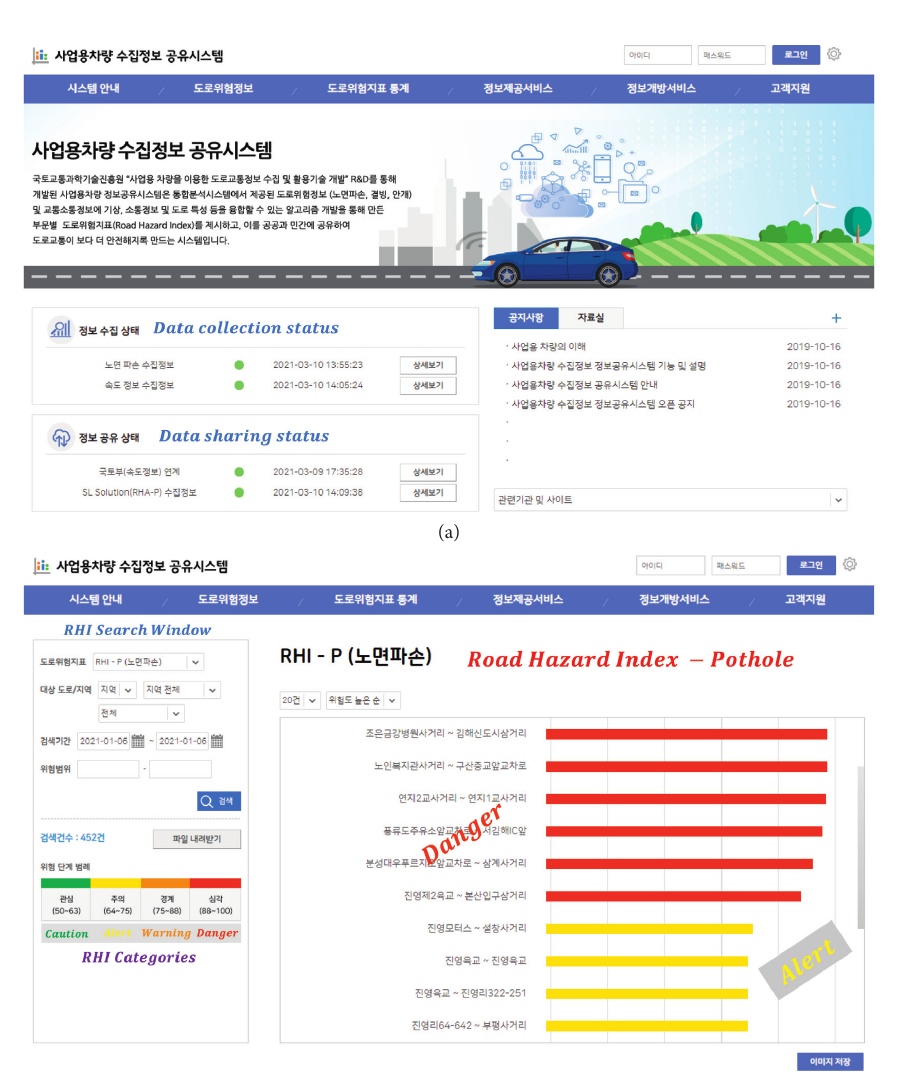
Figure 3: Concept of DAISS.